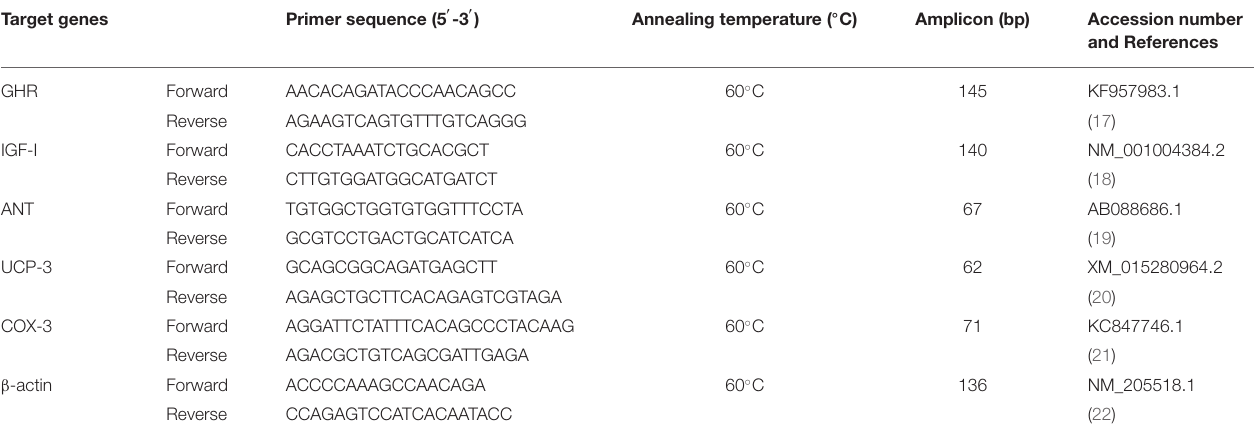
TABLE 2 | Primers of candidate gene used in gene expression analysis.